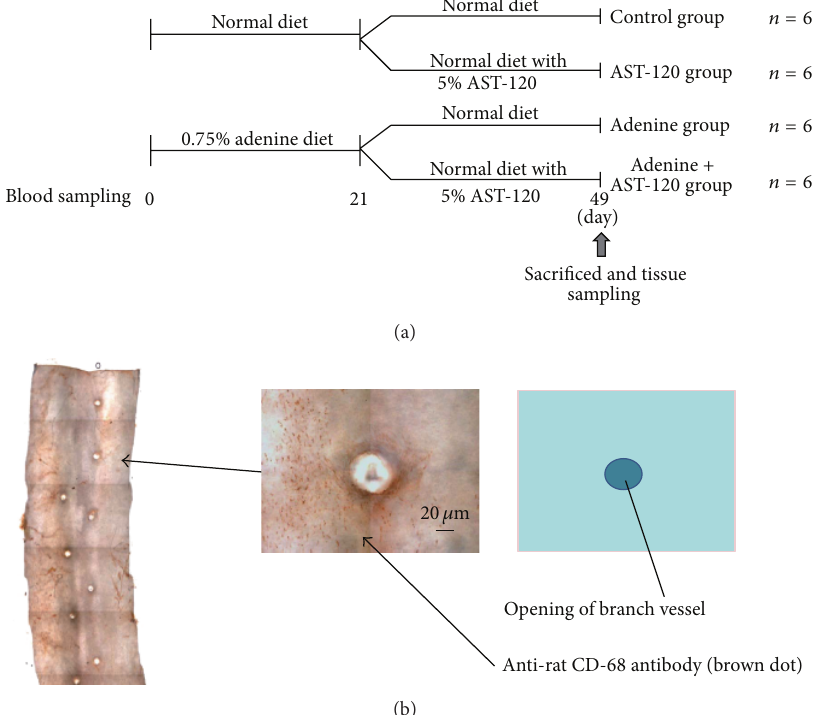
Figure 1: (a) Experimental design and (b) assessment of a new en face method for optimal observation of endothelial surface (NEMOes) number of adherent mononuclear cells.